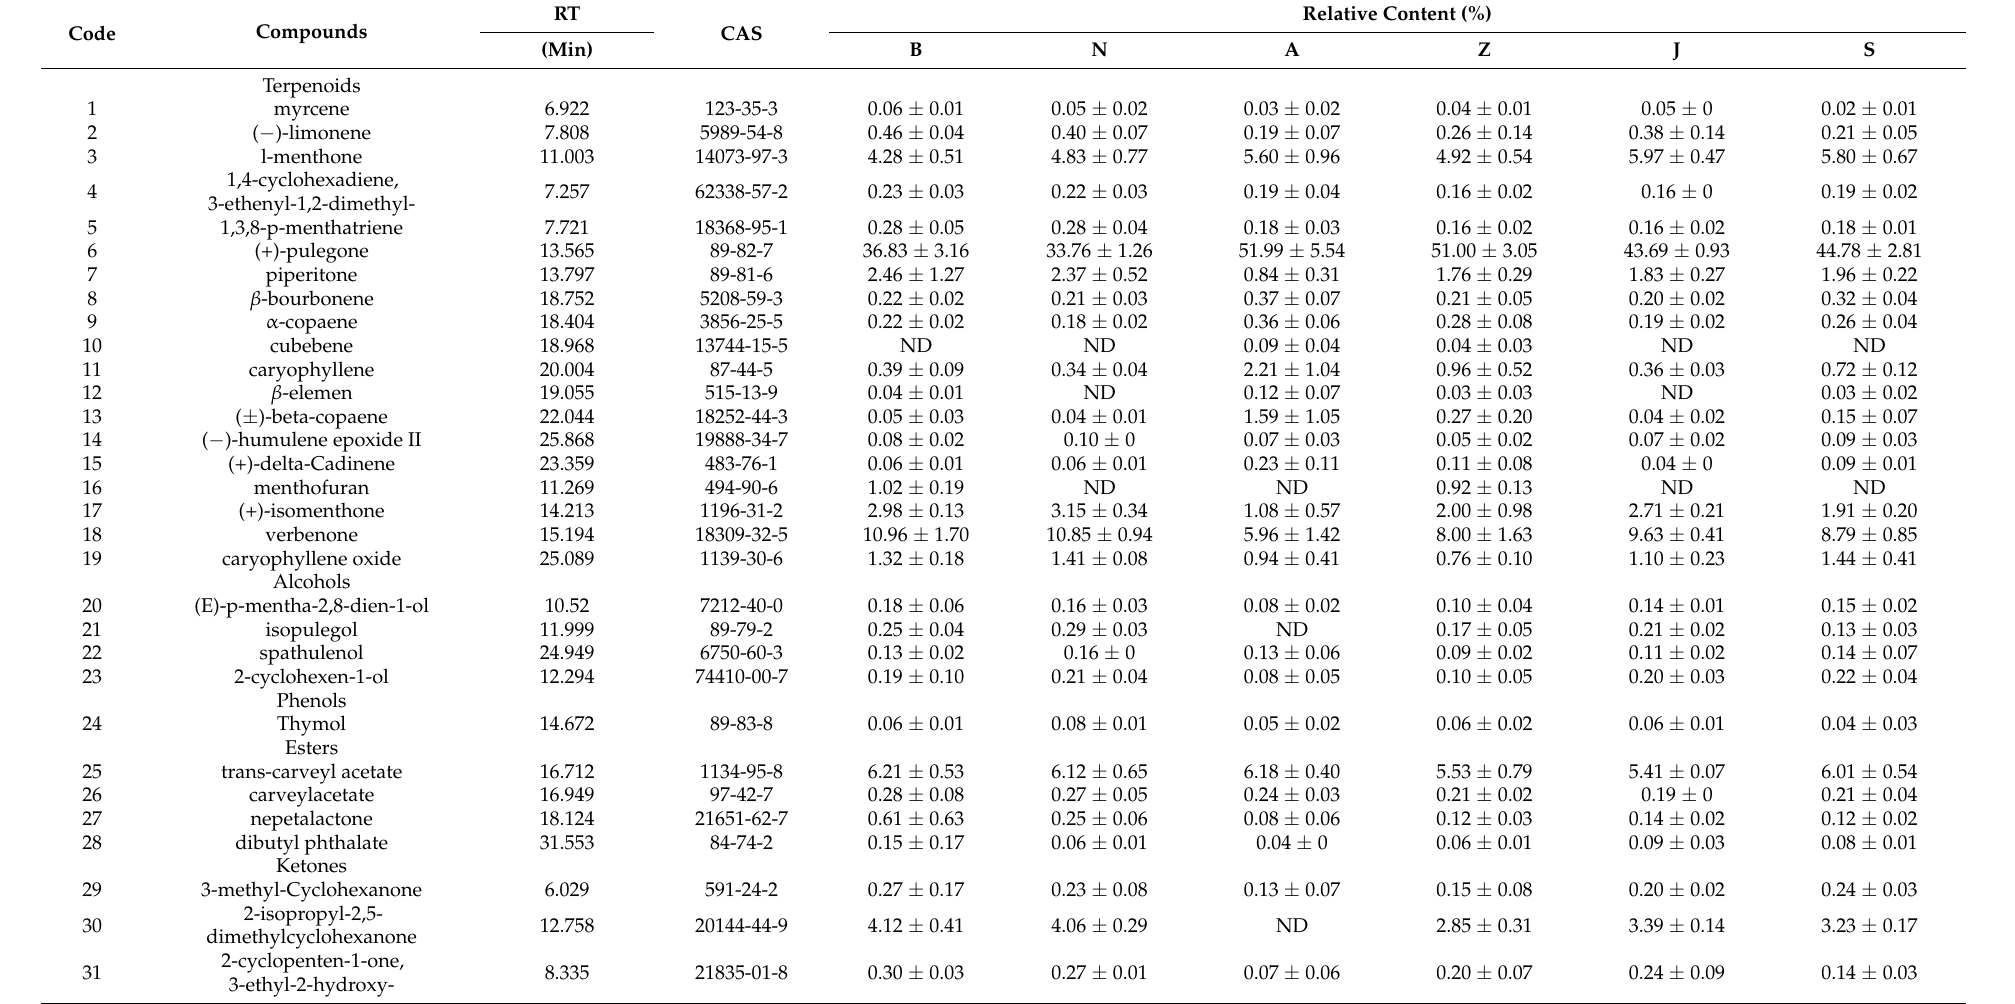
Table 2. The relative contents of VOCs in SS from different regions were determined by